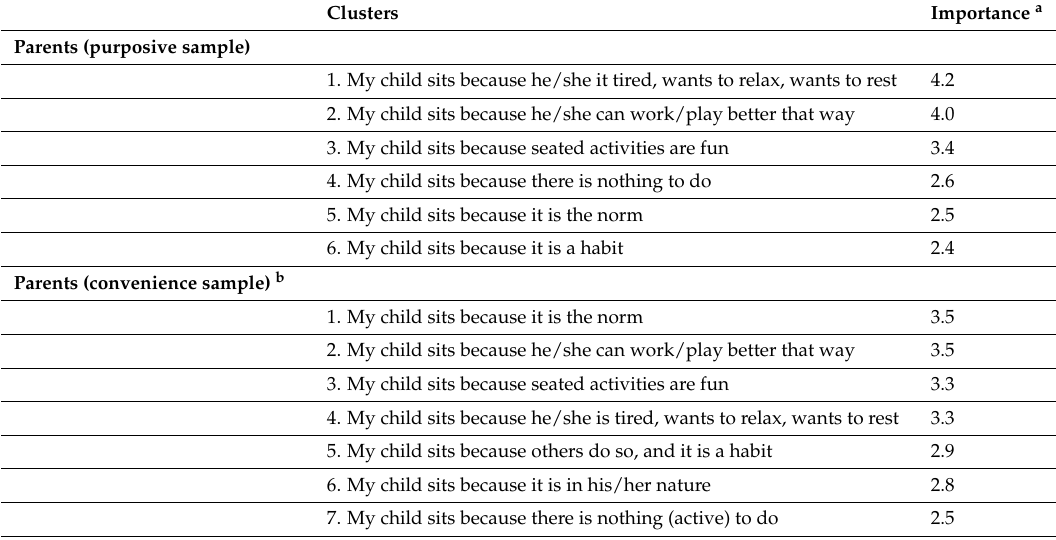
Table 2. Parents’ clusters and average importance ratings.